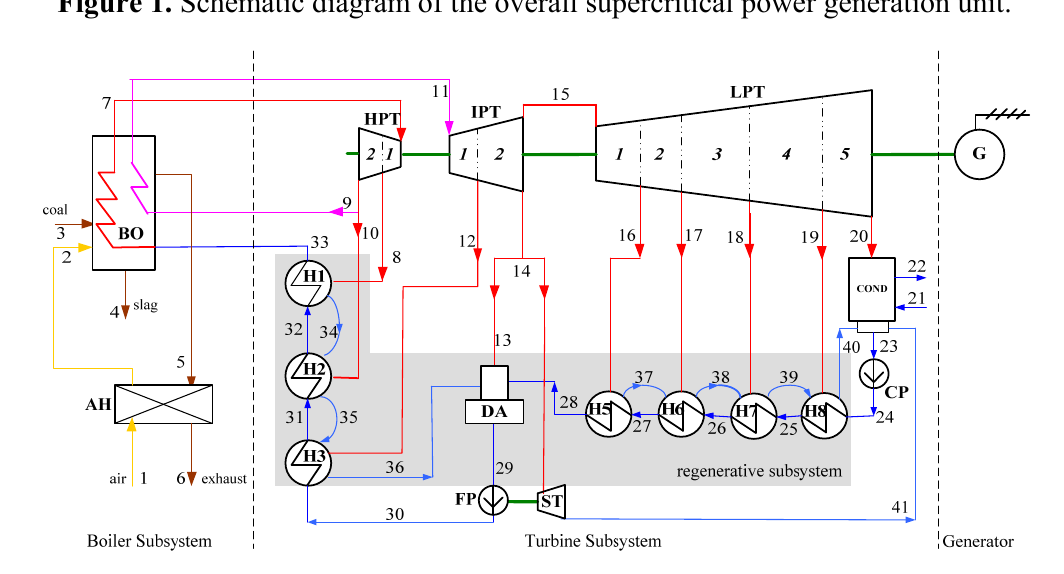
Figure 1. Schematic diagram of the overall supercritical power generation unit.